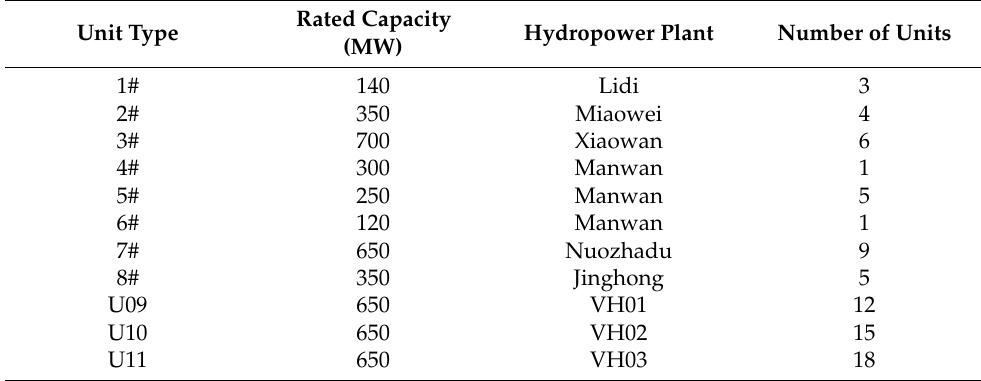
Table 1. Profile of installed units in hydropower